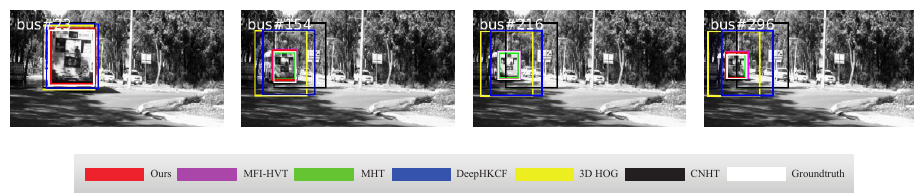
Figure 11. Qualitative results on the ball sequence.